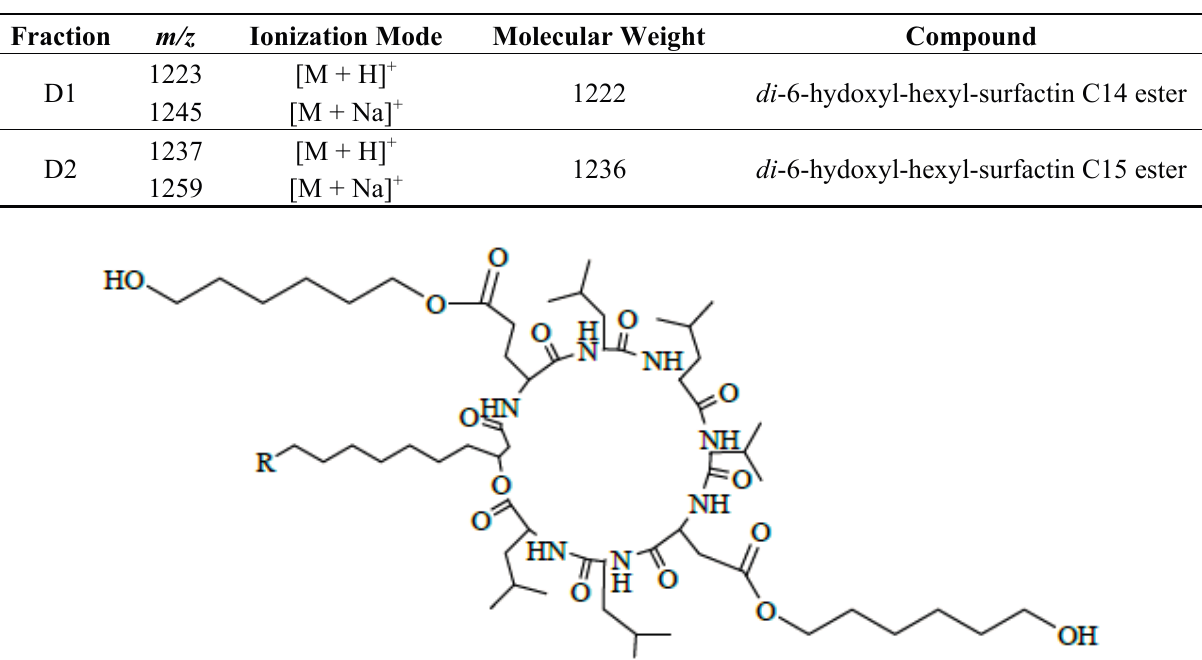
Figure 12. ESI-MS spectroscopy of D1 and D2. Table 3. Component identification results of D1 and D2.